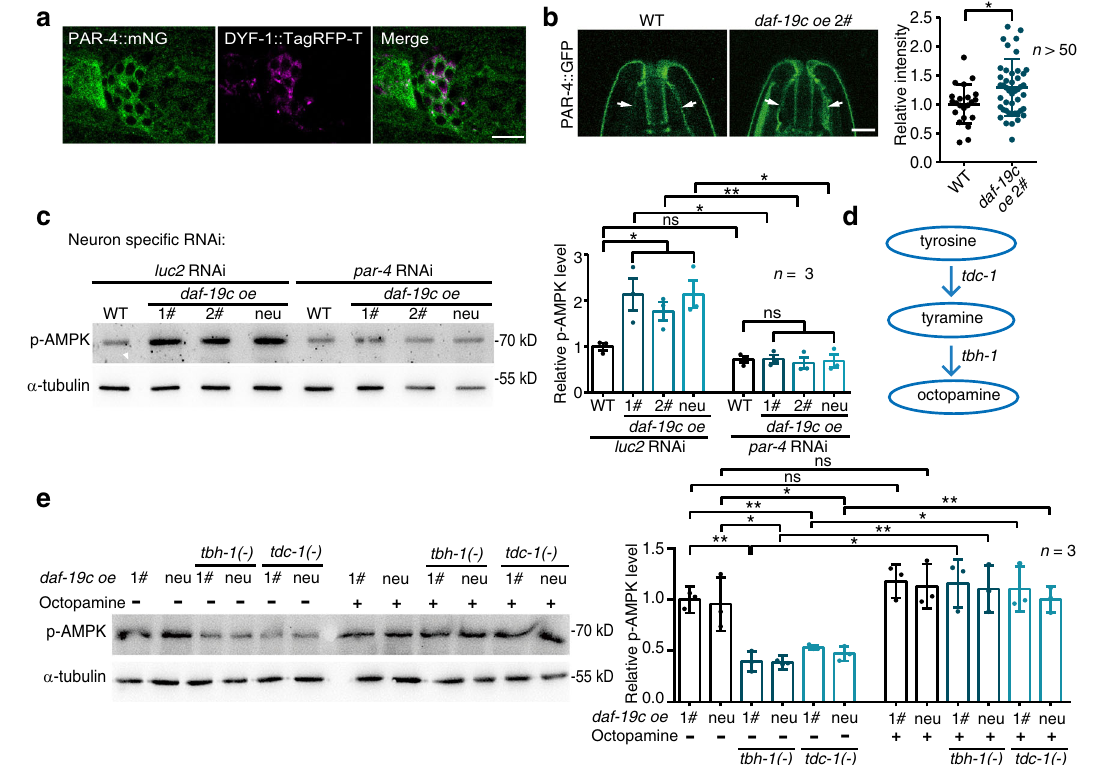
Fig. 5 The enhanced sensory perception upregulates AMPK activity through par-4 and octopamine. a PAR-4 (green) is expressed in neurons, including sensory neurons. Similar results were obtained in all independent experiments. The endogenous par-4 gene was tagged with mNeonGreen (mNG) using CRISPR/Cas9 technology. DYF-1::TagRFP-T (magenta) marks sensory neurons. Scale bar: 10 μ m. b The ciliary localisation of PAR-4::GFP (arrows) is enhanced by overexpressing daf-19c . Scale bar: 5 μ m. n = 66 and 58 animals, respectively. p = 0.0233. c The neuron-speci fi c RNAi against par-4 blocks the upregulation of p-AMPK in worms overexpressing daf-19c . n = 3 biological independent experiments. Exact p value are included in Source Data fi le. d tdc-1 and tbh-1 are two genes encoding critical enzymes in octopamine synthesis. e The levels of p-AMPK in the indicated worms. Worms were collected at day 1 of adulthood post 30 min of 4 mM octopamine or mock treatment. n = 3 biological independent experiments. Exact p values are included in Source Data fi le. α -tubulin serves as loading controls in western blot assays. Data are presented as mean ± SEM in c and mean ± SD in the rest. Unpaired t -test (two- tailed) in b , c , one-way ANOVA in e , * p < 0.05, ** p < 0.01, *** p < 0.001, ns non-signi fi cant. Source data are provided as a Source Data fi